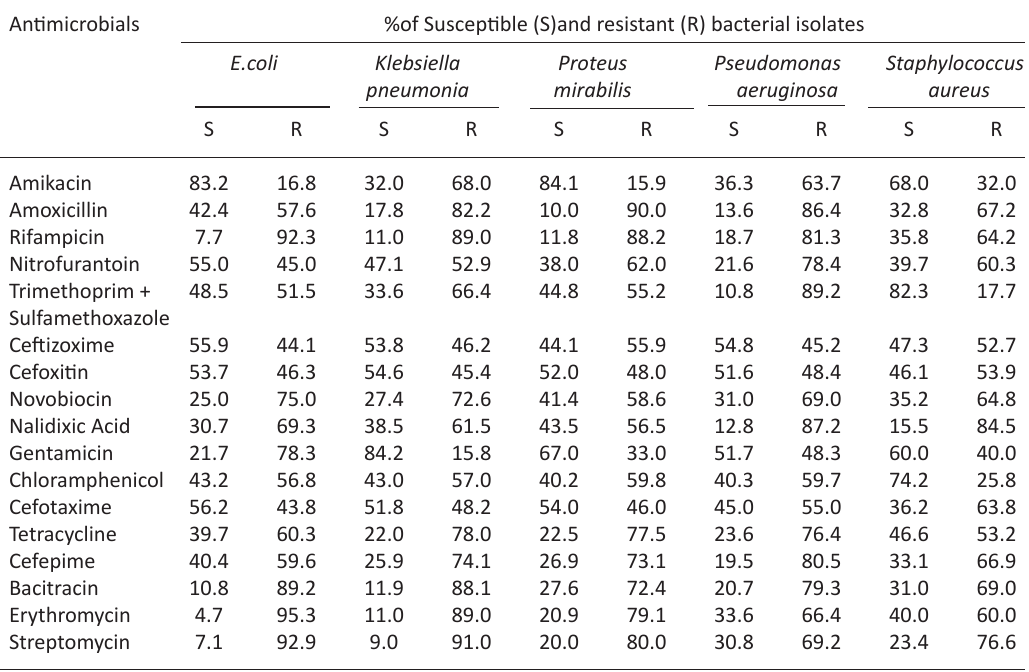
Table2. Antimicrobial sensitivity of the isolated bacteria from urine samples of102UTI patientsin Basra, south of Iraq Antimicrobials %of Susceptible (S)and resistant (R) bacterial isolates